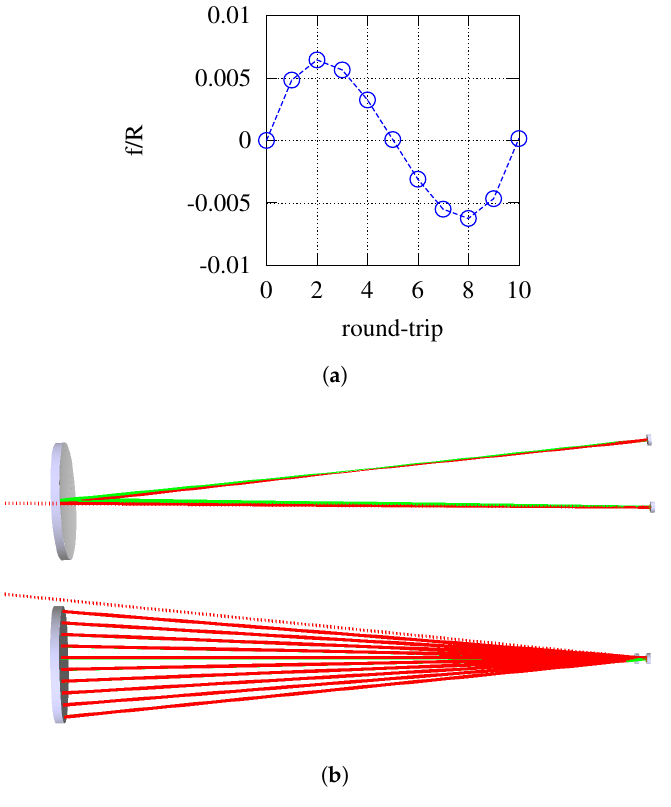
Figure 11. Compensated Type II system with d = 200mm and f = 500mm for 10 round-trips. ( a ) Astigmatic wavefront deformation as a function of round-trip number as a result of a ray-tracing calculation; ( b ) different views of the compensated Type II